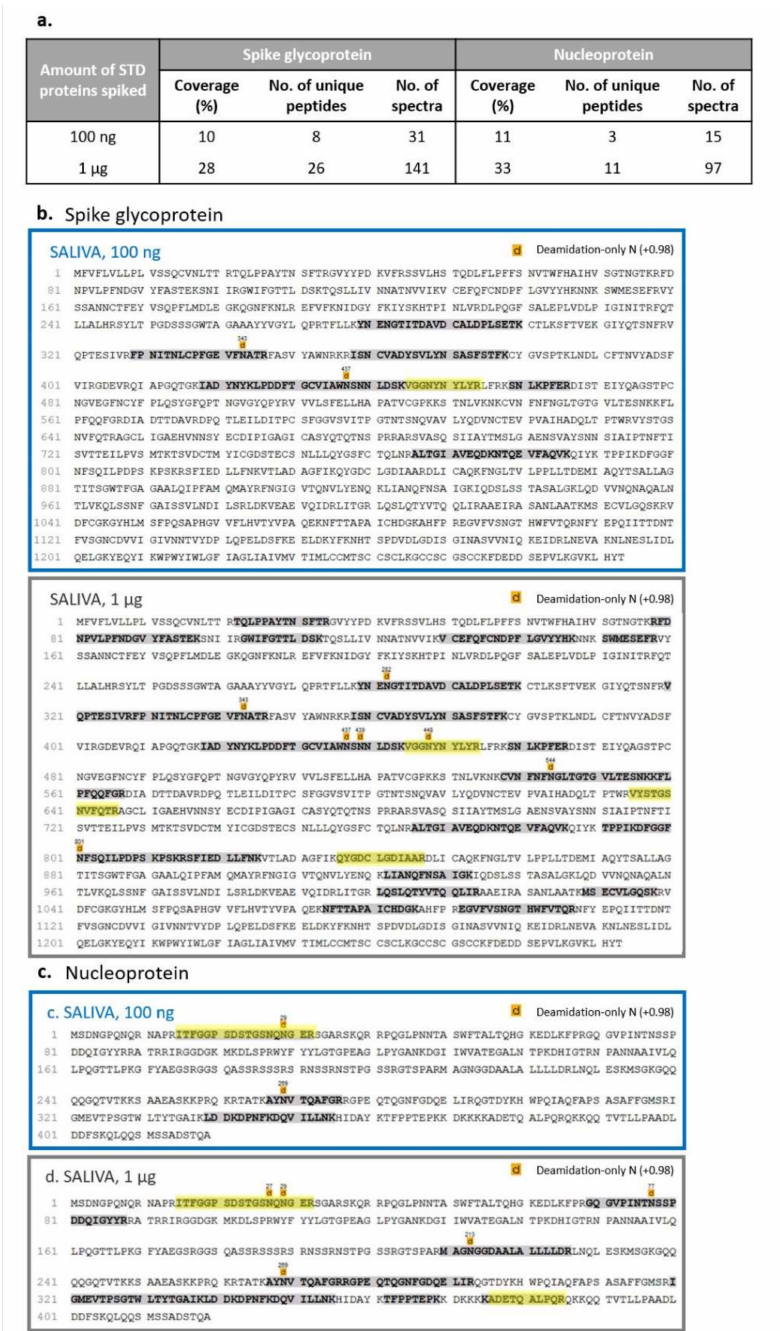
Figure 9. Sequence coverage of the spike glycoprotein and the nucleoprotein in saliva (pre-digestion). Summary table of the results obtained by spiking saliva samples with 100 ng and 1 µ g of each purified SARS-CoV-2 protein (S1, S2, RBD and N) before digestion ( a ). Peptides identified for the spike glycoprotein ( b ) and the nucleoprotein ( c ) analysing 100 ng and 1 µ g of each purified SARS- CoV-2 protein spiked into saliva before digestion. Possible sites of N-glycosylation are identified with letter d and the number of the AA sequence. The sequence covered is in bold and highlighted in grey or yellow, peptides highlighted in yellow are those also observed in the